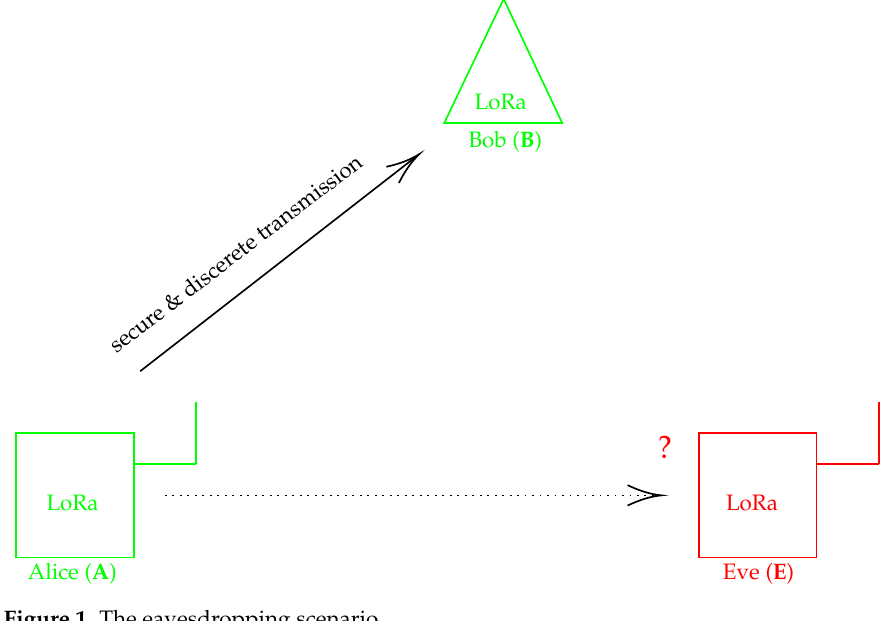
Figure 1. The eavesdropping scenario.